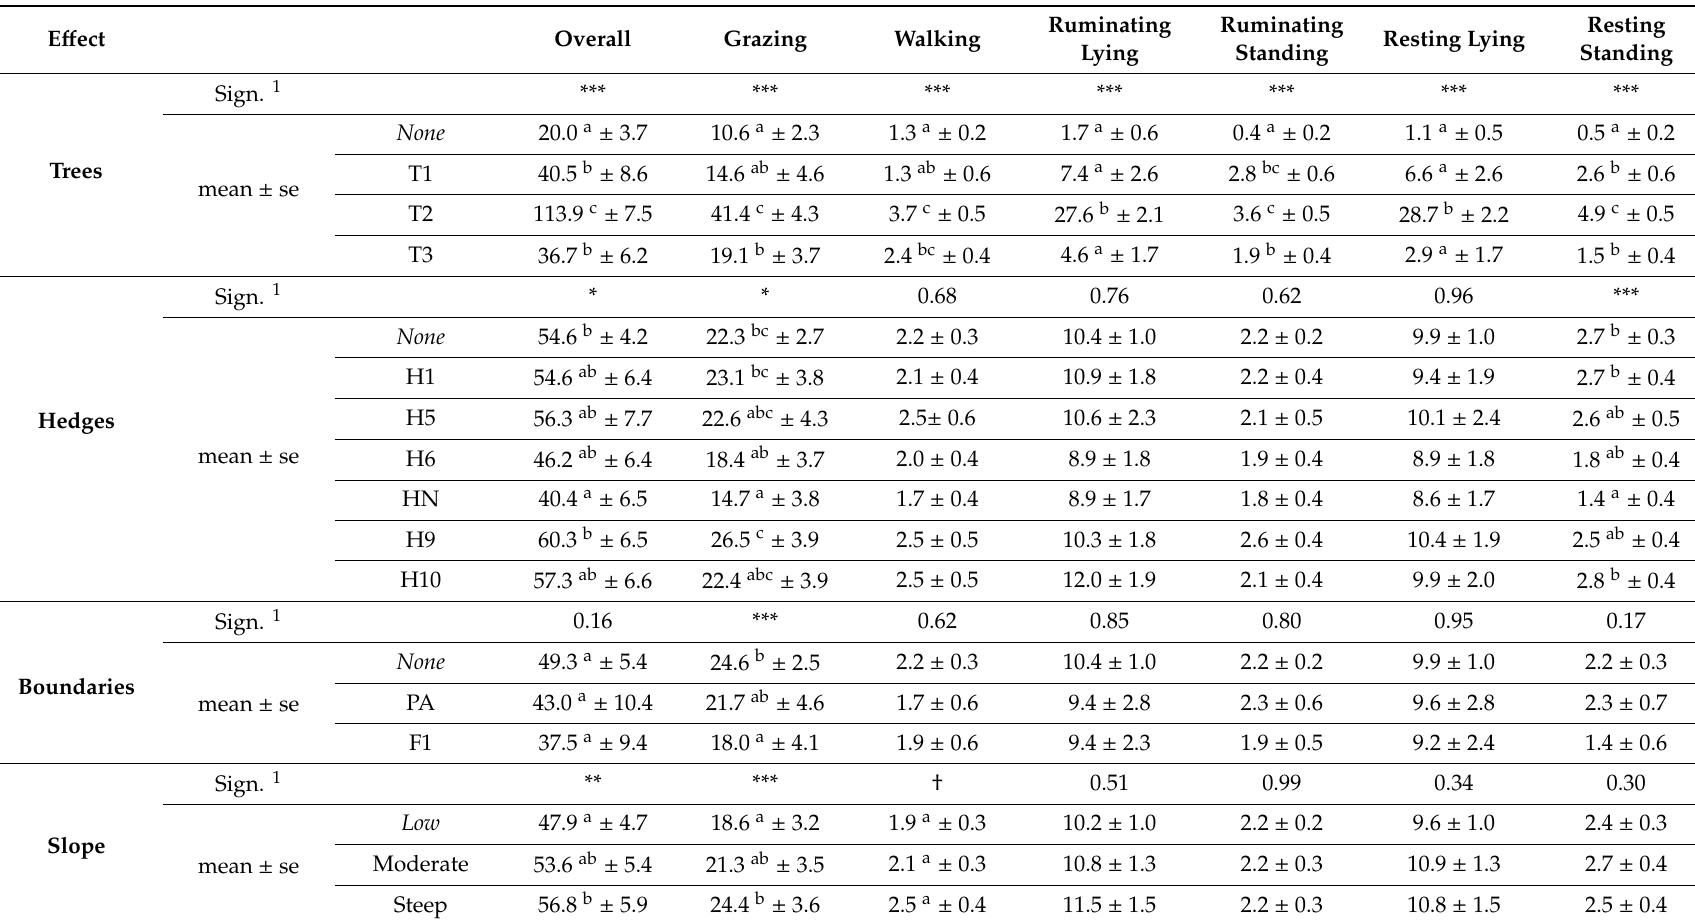
Table 2. E ff ect of the pasture characteristics on the overall cow location and time-budget expressed in seconds per surface unit of 8 m × 8 m, per cow and per day in the permanent grassland. E ff ect Overall Grazing Walking